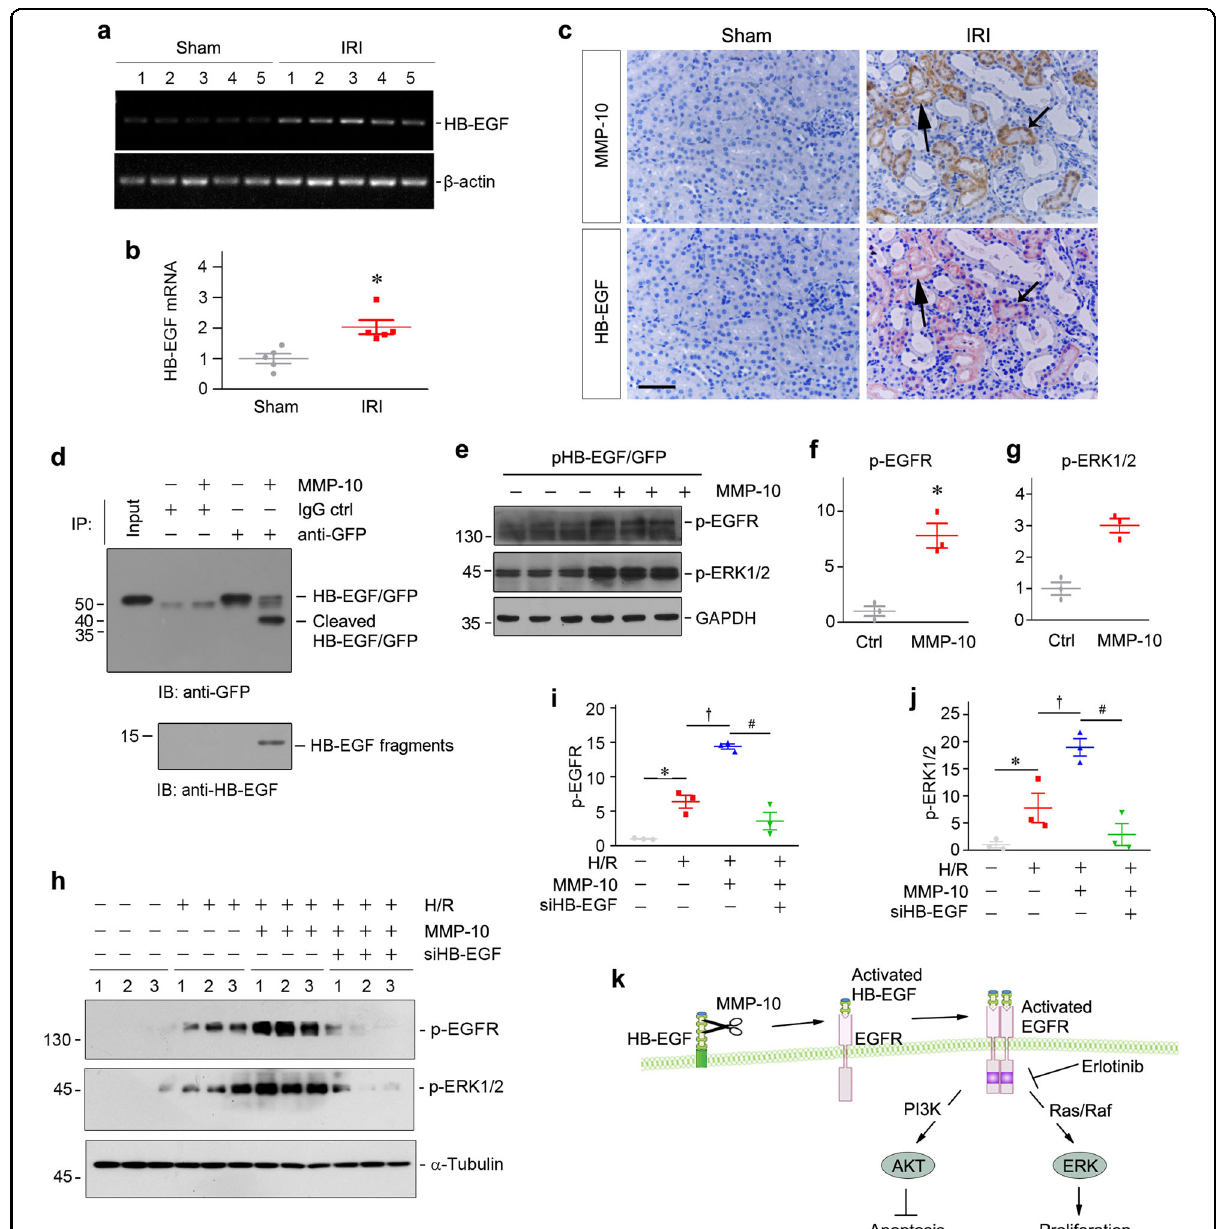
Fig. 8 MMP-10 cleaves HB-EGF and activates HB-EGF/EGFR signaling. a , b RT-PCR results show renal mRNA expression of HB-EGF at 24 h after IRI. Representative RT-PCR results ( a ) and quantitative data (fold induction over the sham control) ( b ) are presented. * P < 0.05 versus sham controls ( n = 5). c Colocalization of MMP-10 and HB-EGF in renal tubules at 24 h after IRI. Kidney serial sections were immunostained for MMP-10 and HB-EGF, respectively. Arrows indicates the colocalization of MMP-10 and HB-EGF in renal tubules. Scale bar, 50 µm. d MMP-10 proteolytically cleaves HB-EGF in vitro. HKC-8 cells were transfected with HB-EGF-GFP fusion protein expression vector (pHB-EGF-GFP). The fusion protein in the HKC-8 cell lysates was immunoprecipitated with anti-GFP antibody, followed by incubation with rhMMP-10 for 2 h. After enzymatic cleavage, the supernatant and the beads containing the C-terminal remaining portion of the HB-EGF fusion protein were analyzed by western blot analysis. e Representative Western blots show protein expression of p-EGFR (Tyr845) and p-ERK1/2 (Thr202/Tyr204) after MMP-10 treatment in HKC-8 cells. f , g Graphic presentations show the relative abundances of p-EGFR ( f ) and p-ERK1/2 ( g ) in different groups as indicated. * P < 0.05 versus cells without rhMMP-10 incubation ( n = 3). h – j Knockdown of HB-EGF by siRNA abolishes MMP-10-mediated EGFR and ERK1/2 activation. Western blotting ( h ) and quantitative data show protein level of p-EGFR ( i ) and p-ERK1/2 ( j ) after various treatments as indicated. * P < 0.05 versus control cells; † P < 0.05 versus H/R alone; # P < 0.05 versus H/R with MMP-10 ( n = 3). k Schematic presentation depicts the potential mechanism by which MMP-10 protects against AKI. MMP- 10 possesses the ability to cleave HB-EGF, the ligand of EGFR. This leads to the binding of cleaved HB-EGF to EGFR and activates downstream signaling of AKT and ERK, respectively, leading to tubular cell survival and